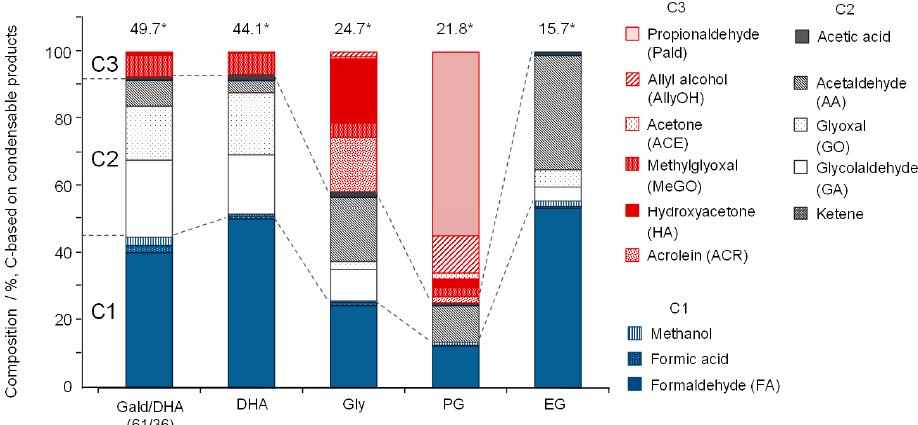
Figure 6. Composition (%, C-based) of condensable products from glyceraldehyde (Gald) / 1,3- dihydroxyacetone (DHA) (61 / 36, mol / mol), DHA, glycerol (Gly), propylene glycol (PG), and ethylene glycol (EG) at 600 ◦ C (residence time of 0.9 s under N 2 flow of 400 mL min − 1 ). * Yield (%, C-based) of the condensable product. The data of Gald / DHA, DHA and Gly are from literature